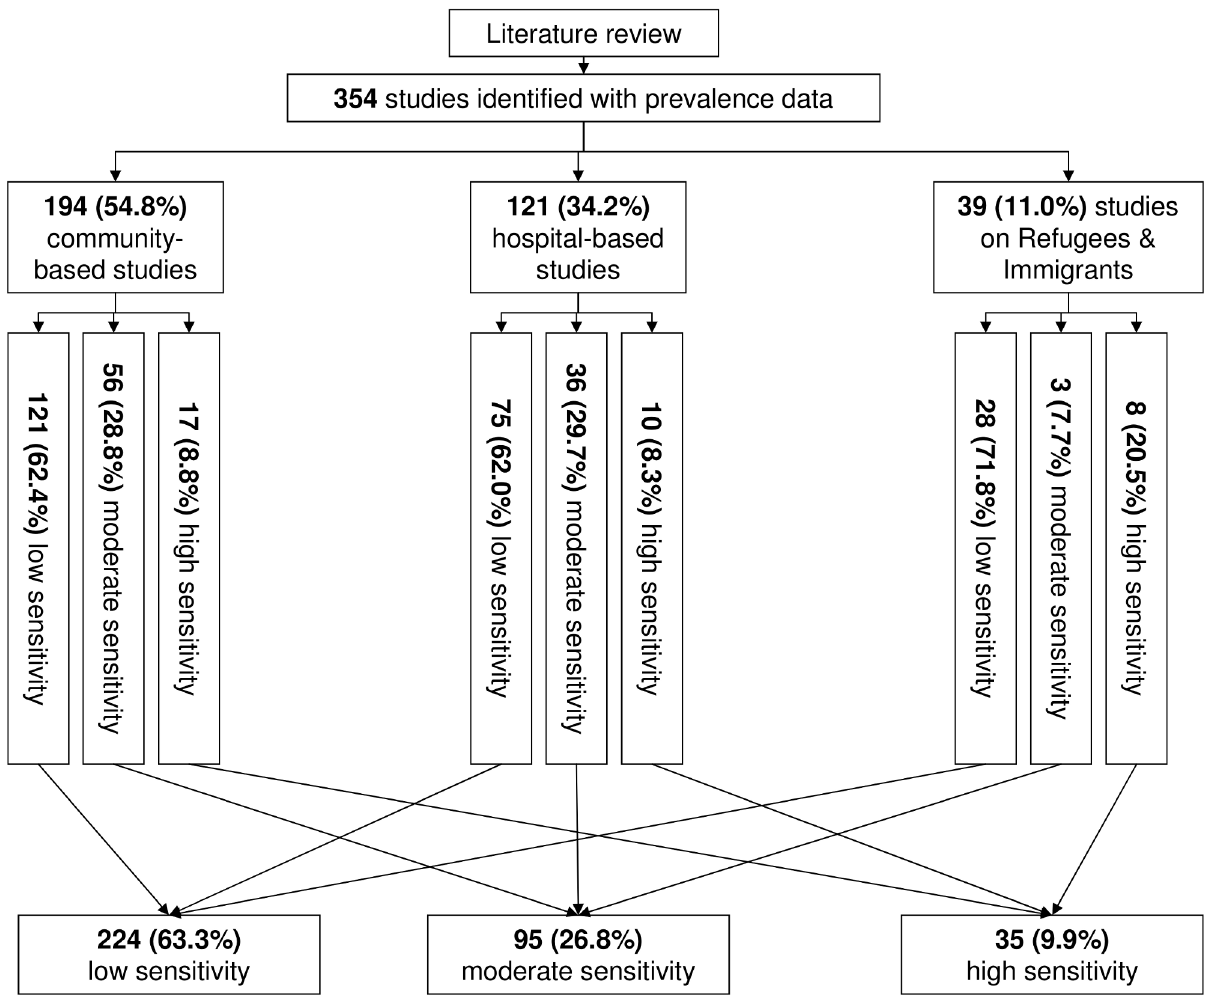
Figure 2. Flowchart of the literature review.